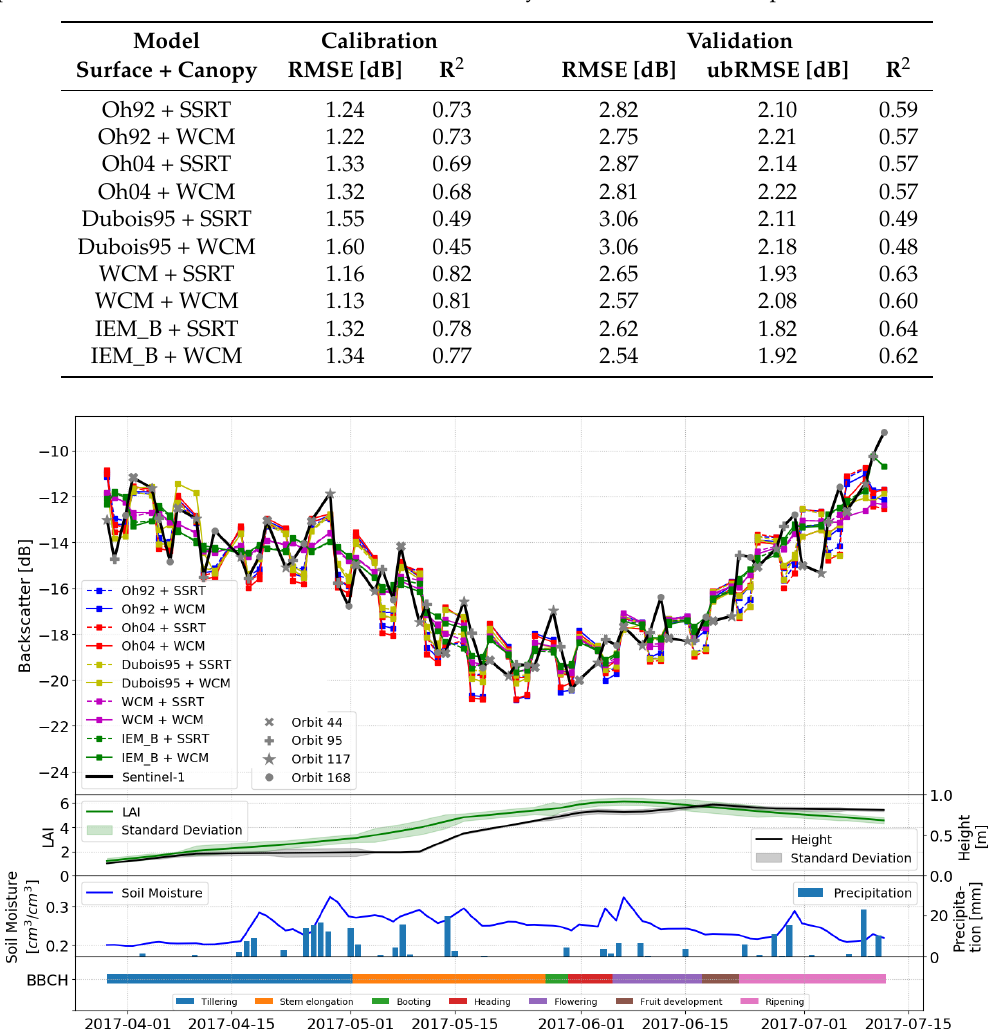
Figure 6. Measured and modeled data (non-static parameters) of wheat field 508 for vegetation period 2017. VV-polarized backscatter comparison of different model combinations (surface + canopy) with non-static empirical parameters and Sentinel-1 data. Different icons represent different acquisition geometries of Sentinel-1 ( top ). Field measurements of LAI, canopy height, and soil moisture, as well as precipitation data from meteorological station Freising ( middle ). Observed vegetation phenology according to BBCH scale [84] ( bottom